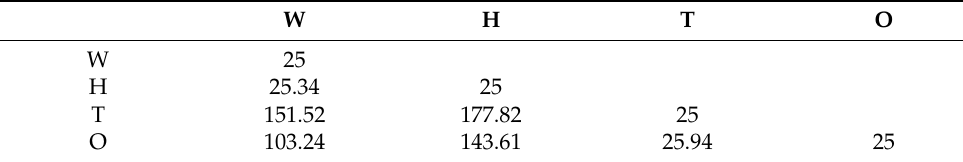
Table 1. The interaction parameters employed in this